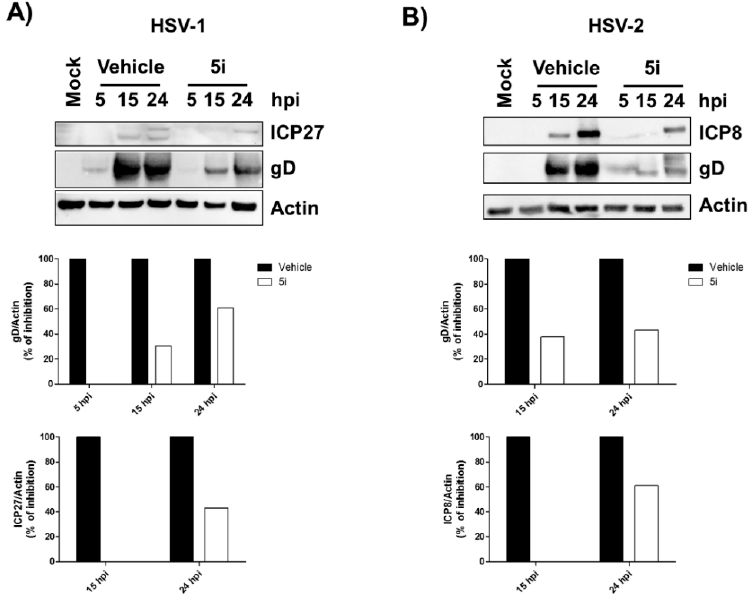
Figure 5. Vero cells were mock infected or infected with HSV-1 ( A ) or HSV-2 ( B ) at an MOI of 0.3. Protein levels of ICP27 (HSV-1), ICP8 (HSV-2) and gD (HSV-1/2) were assessed at different times post infection (hpi) by Western blotting (upper panels). Viral proteins were subjected to densitometry and normalized to Actin, serving as a loading control (lower panels).